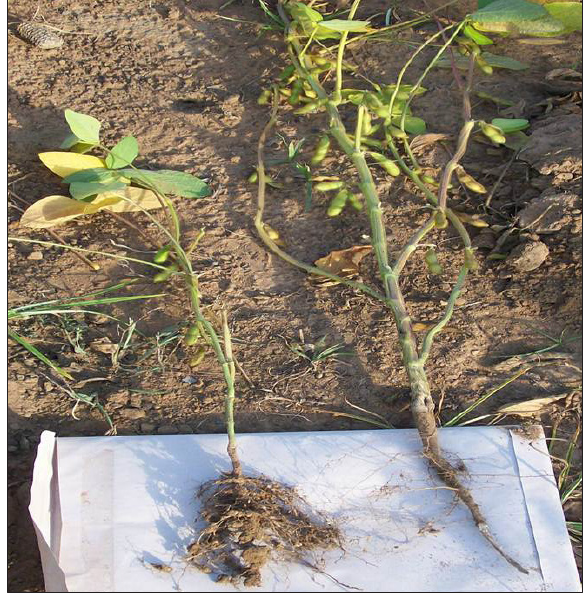
Figure 2: The swollen, roundish body of a red-stained female root-knot nematode positioned with her neck embedded in root cells in the vascular cylinder of the soybean plant in which she is feeding.